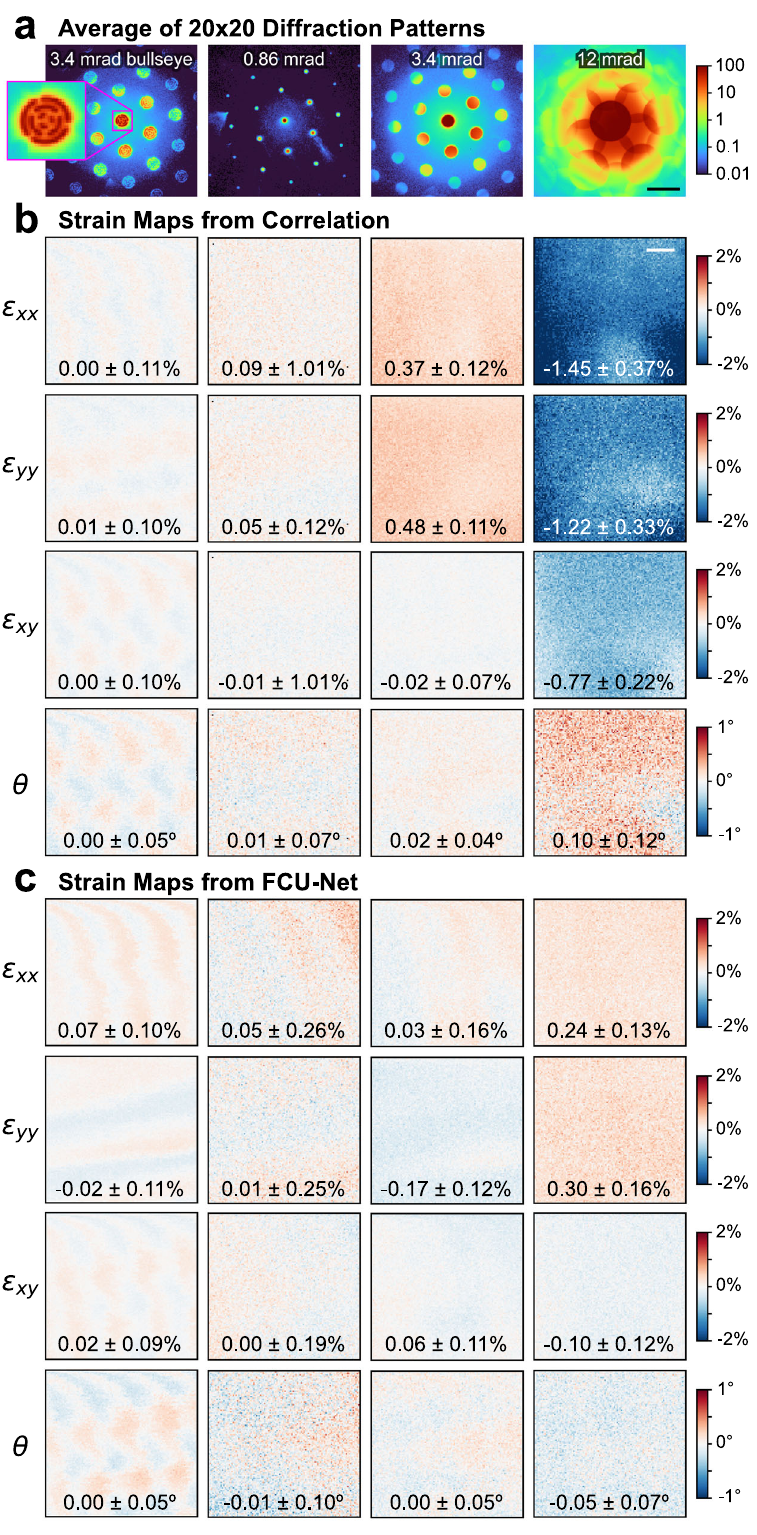
Fig. 5 Experimental strain maps measured from single crystal hexagonal-boronitride thin fi lms. a Mean diffraction images of 20x20 probe positions, for STEM probes de fi ned by 3.4, 0.86, 3.4, and 12 mrad semiangle apertures, where the leftmost aperture also contains a bullseye pattern. Scale bar is equal to 1 Å − 1. b Strain maps measured using cross-correlation template matching for the 4 cases given above. c Strain maps measured using the FCU-Net network predictions. For all maps, the mean and standard deviation strains/angles are inset, relative to the correlation bullseye 3.4 mrads measurement. Scale bar is equal to 200